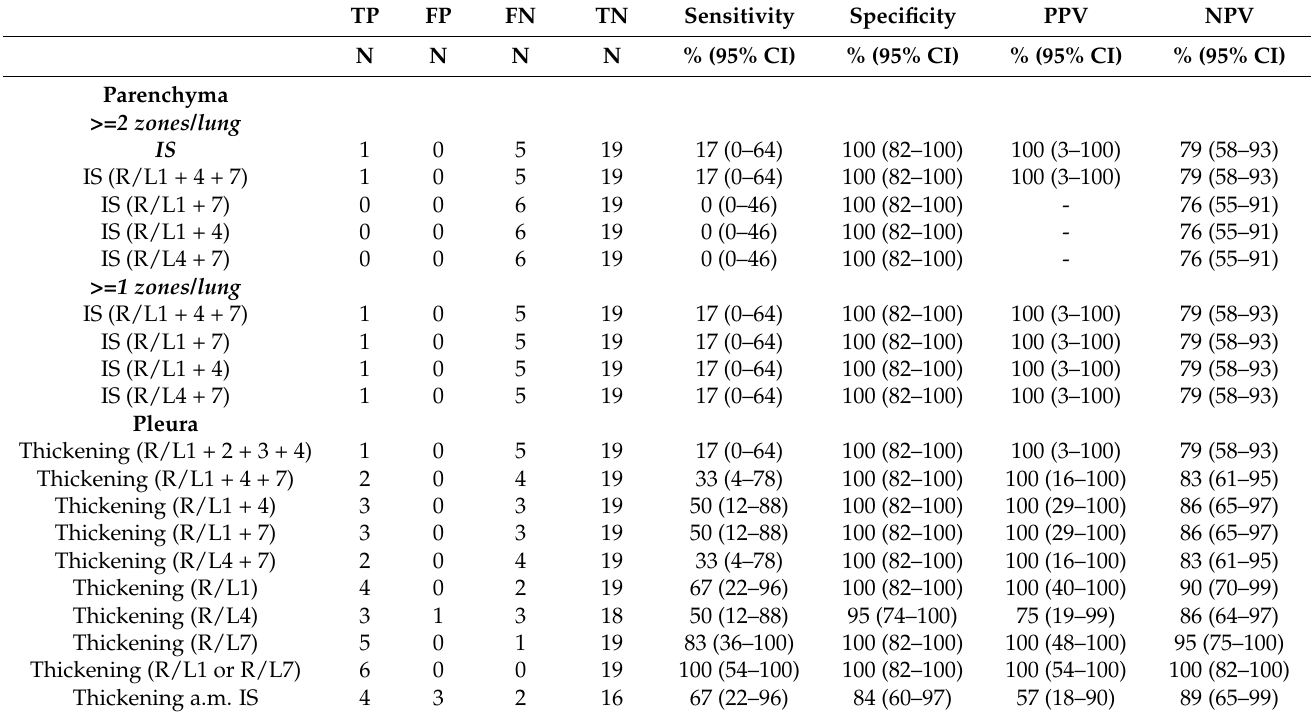
Table 4. Diagnostic accuracy for IS and pleural thickening according to predefined LUS scanning zones in patients with RAS. TP FP FN TN